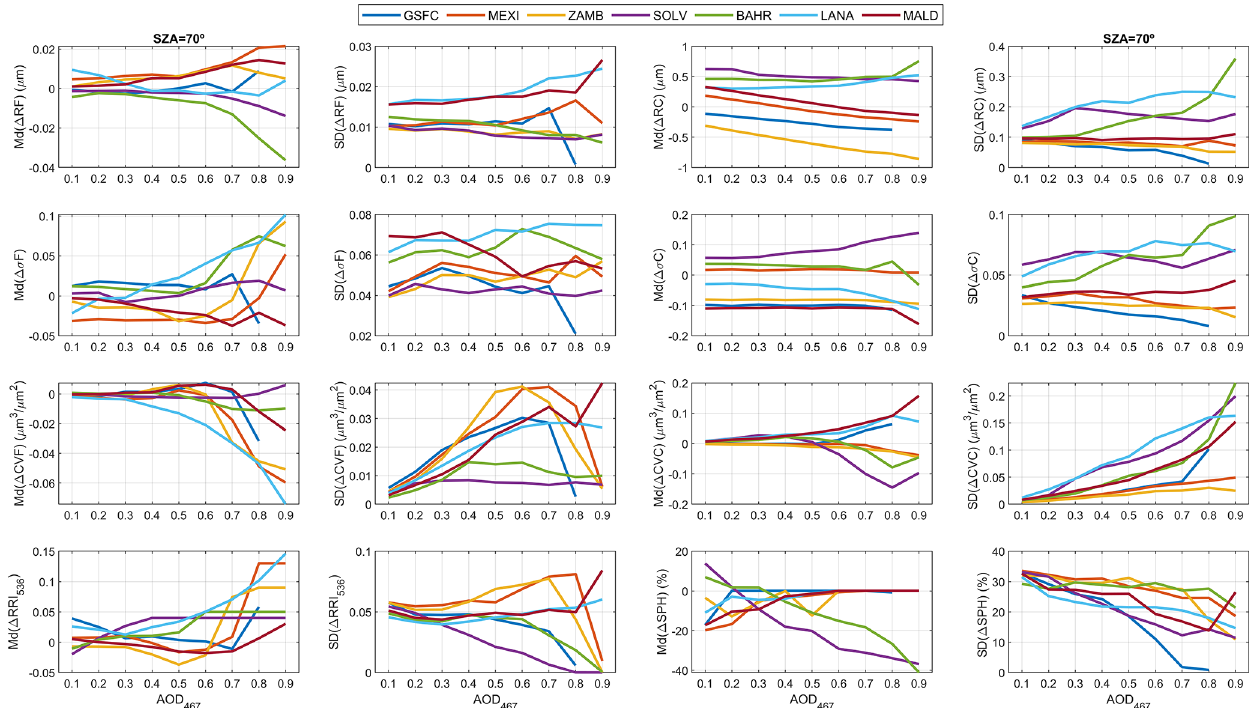
Figure 7. Median (Md) and standard deviation (SD) of the (cid:49) differences between the available retrieved aerosol properties with noise and the original ones for solar zenith angle (SZA) of 70 ◦ . The aerosol properties are volume median radius of fine (RF) and coarse (RC) modes, standard deviation of log-normal distribution for fine ( σ F) and coarse ( σ C) modes, aerosol volume concentration for fine (VCF) and coarse (VCC) modes, real part of refractive index at 536nm (RRI 536 ), and the fraction of spherical particles (SPH). These Md and SD values are represented as a function of AOD 467 for different aerosol